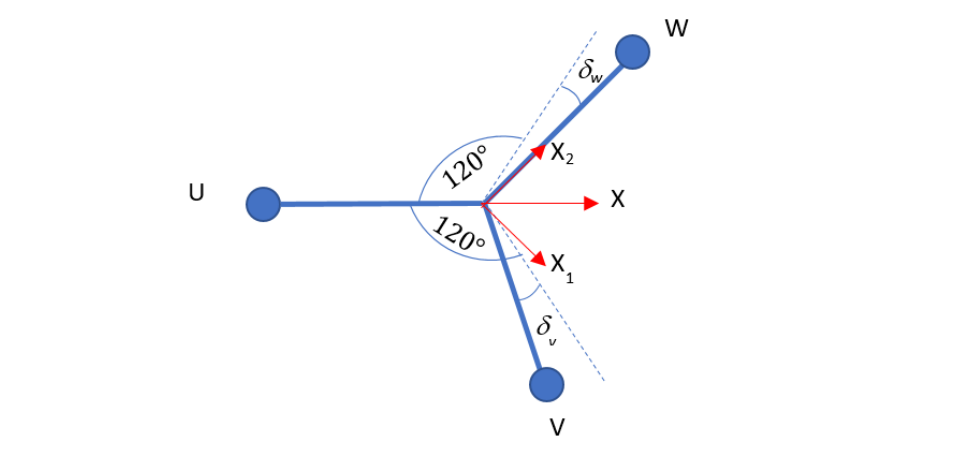
Figure A1. Top view of the triaxial seismometer where V and W component seismometer is not aligned with the ideal symmetric orientations shown by the dashed lines but deviate from them by angles of δ v and δ w